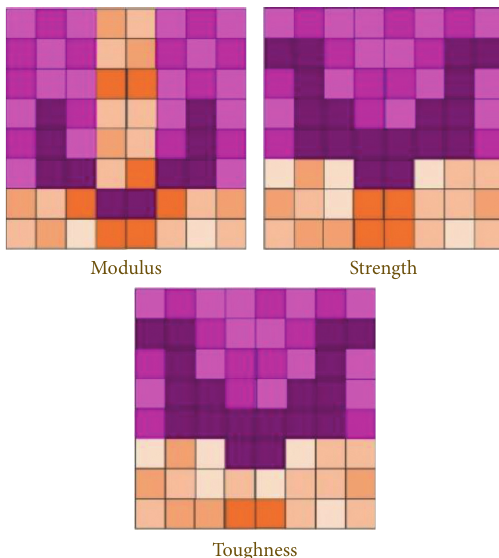
Figure 9: 8 × 8 grid weights